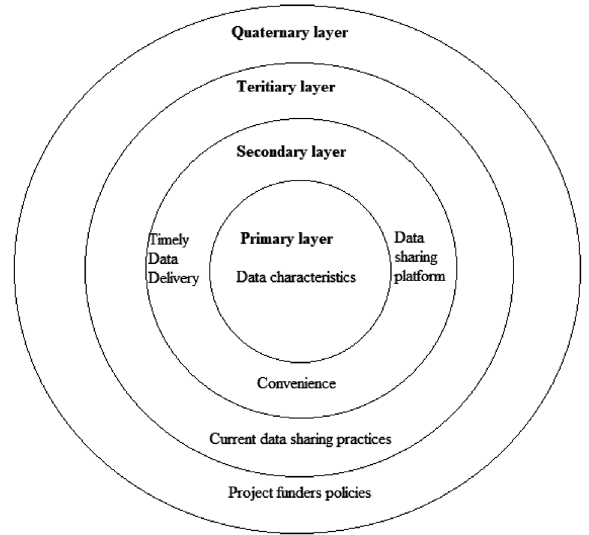
Fig. 1: Adopted and modified model for data sharing channel selection (from Snyder & Lee- Partridge,